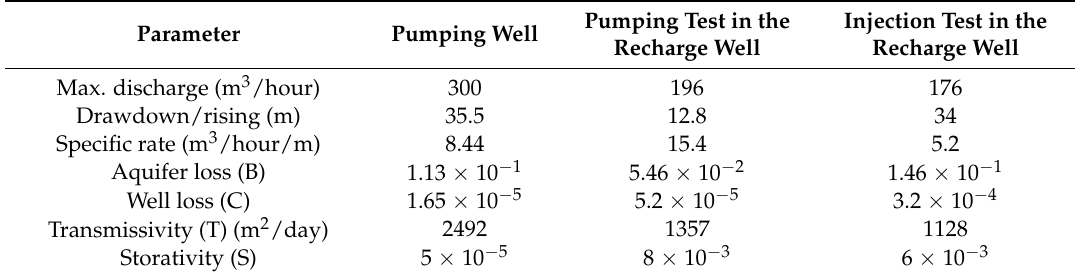
Table 1. Major hydraulic parameters from the pumping and injection tests.